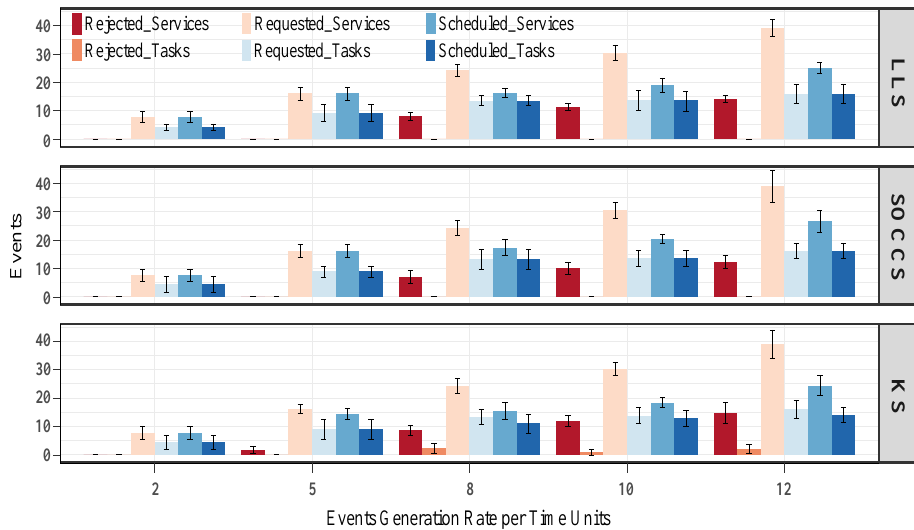
Figure 10. Number of requested, scheduled and rejected events (i.e., services and tasks) for all the scheduling algorithms.